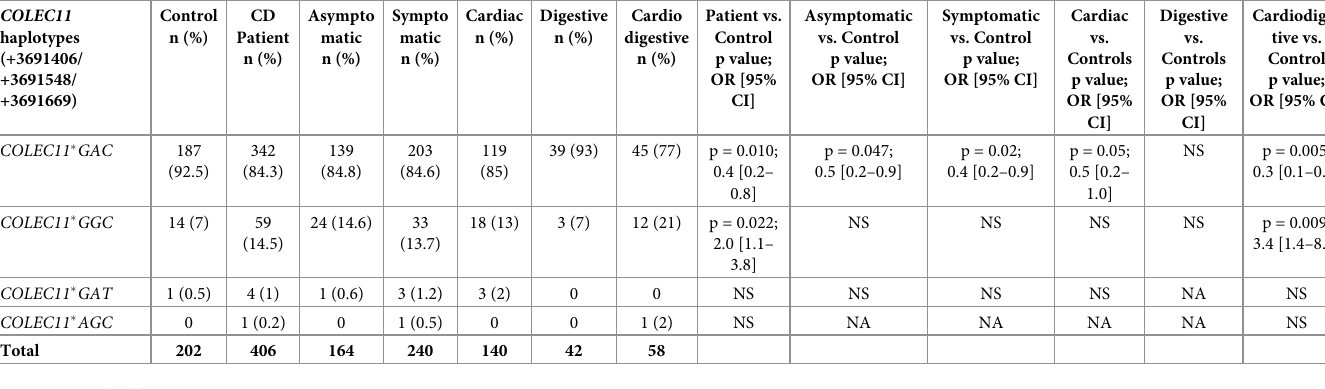
Table 4. Reconstructed COLEC11 haplotypes among patients with chronic CD and healthy